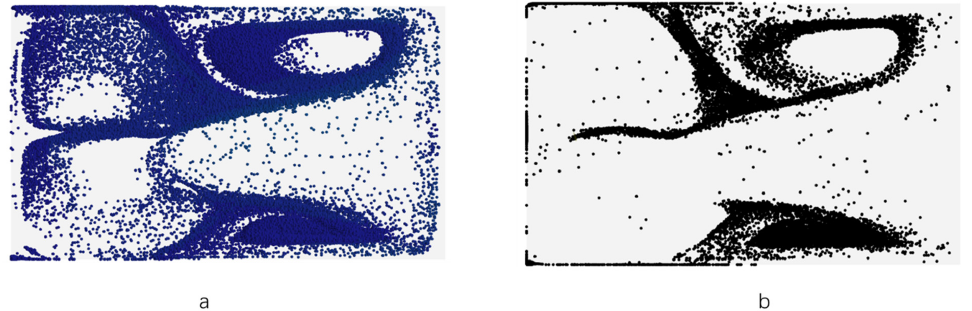
Figure 15. Thermal map of particles distribution in a10.